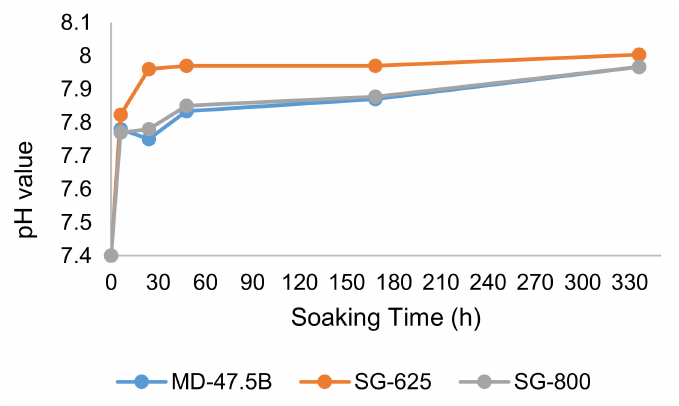
Figure 6. In vitro bioactivity tests: pH increase as a function of the soaking time in simulated body fluid